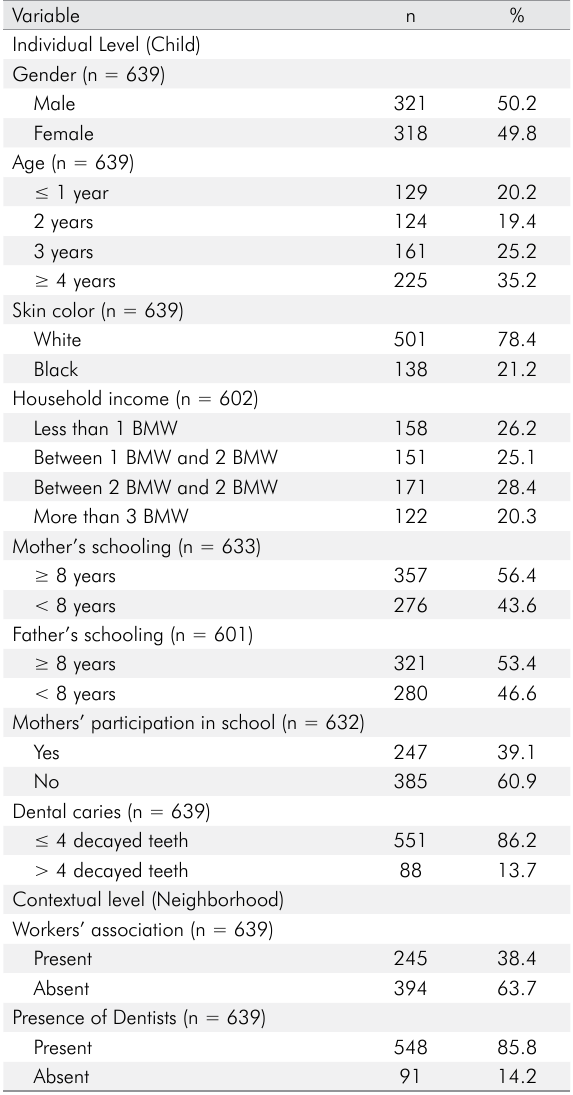
Table 1. Individual and contextual level characteristics of the